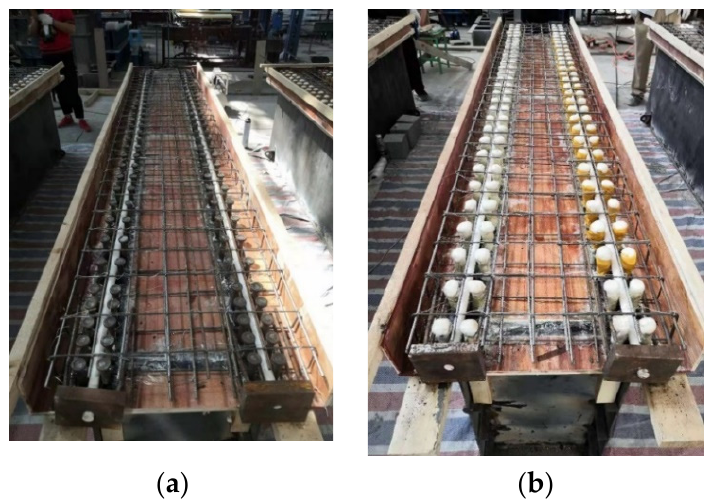
Figure 3. Schematic Diagram for Two Types of Shear Connectors. ( a ) conventional connector for SRB, ( b ) URSP connector for SPB.